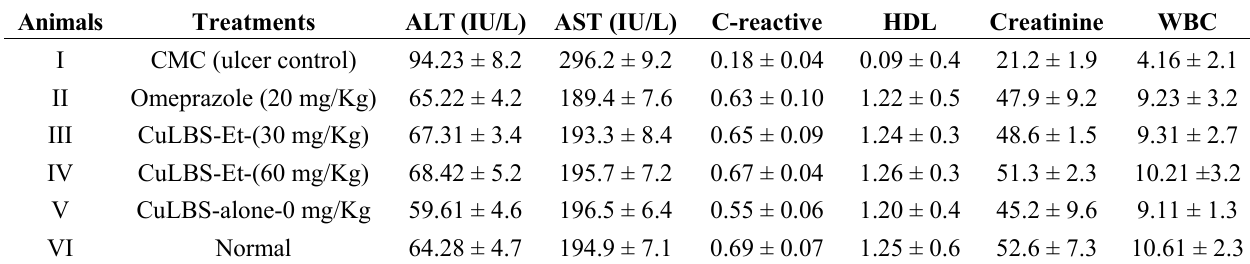
Table 4. Biochemical parameters in gastroprotectivity study of CuLBS. Animals